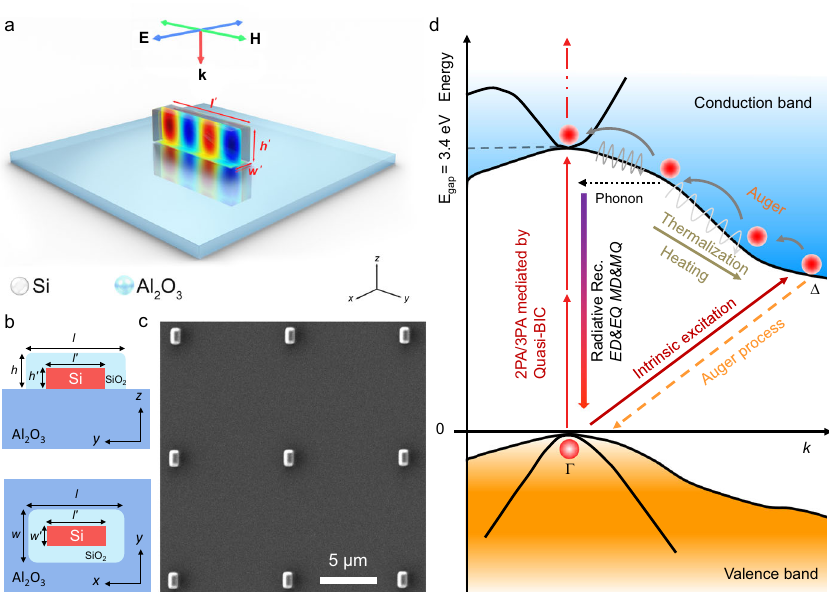
Fig. 1 Structure and morphology of Si/SiO 2 cuboids supporting quasi-BICs and the physical mechanism for ef fi cient white light emission. a Schematic showing a Si cuboid supported by a sapphire (Al 2 O 3 ) substrate. Also shown is the magnetic fi eld distribution at the quasi-BIC. b Schematic showing the detailed structure of a Si/SiO 2 cuboid supported by a sapphire substrate, which is de fi ned by geometrical parameters of l , w , h , l ′ , w ′ , h ′ , and t . c SEM image of a regular array of Si/SiO 2 cuboids. d Schematic showing the physical mechanism for ef fi cient white light emission from Si/SiO 2 cuboids by exploiting the enhanced nonlinear optical absorption at quasi-BICs. Here, ED, EQ, MD, MQ represent electric dipole, electric quadrupole, magnetic dipole, and magnetic quadrupole, respectively. 2PA and 3PA represent two- and three-photon-induced